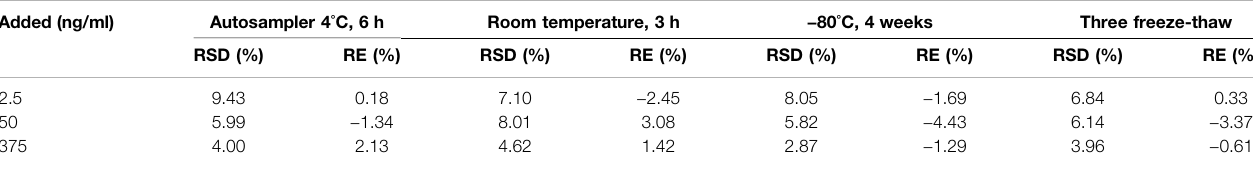
TABLE 3 | Stability of erda fi tinib in beagle dog plasma under different storage conditions ( n (cid:2) 6, each concentration). Added